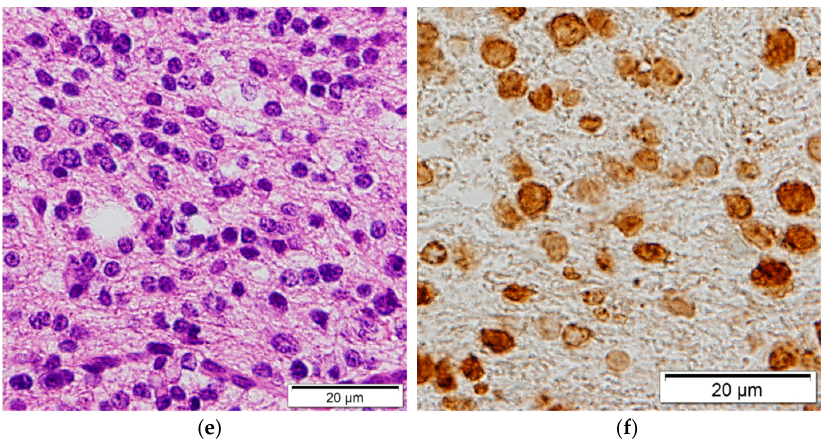
Figure 1. A 60-year-old man presented with headache, diplopia, and ataxia (Case 18). ( a , b ) Magnetic resonance imaging (MRI) and positron emission tomography (PET) revealed a pontine tumor ex- tending also to the right thalamus, bilateral medial temporal lobe, right mesencephalic tegmentum, medulla oblongata, and bilateral cerebellum (maximum diameter: 37 mm, tumor volume: 17.8 mL); the surgical trajectories are set through the right middle cerebellar peduncle to the brainstem tumor, aiming for postoperative neurological preservation by using the FrameLink software installed in StealthStation S7 surgical navigation system (Medtronic plc); ( c ) Surgical setup for stereotactic frame-based biopsy (SFB) of a brainstem tumor. The physical characteristics of this patient are a large head size, short neck, and well-developed occipital muscles. The frame was fixed at four points on the forehead and back of the head by shifting the frontal pins slightly upward from the orbitomeatal baseline (arrow), to reduce the possibility of interference with the surgical field, which comprised a skin incision and burr hole; ( d ) No hemorrhage was observed on the MRI performed within 24 h after surgery. The tumor specimen was obtained from the targeted location (right middle cerebellar peduncle; arrowhead); ( e ) Histologic features of a diffuse midline glioma. Hematoxylin and eosin staining showing the diffuse growth of atypical glia cells with round nuclei; ( f ) Immunohistologic staining showing that the atypical cells are positive for H3K27M.